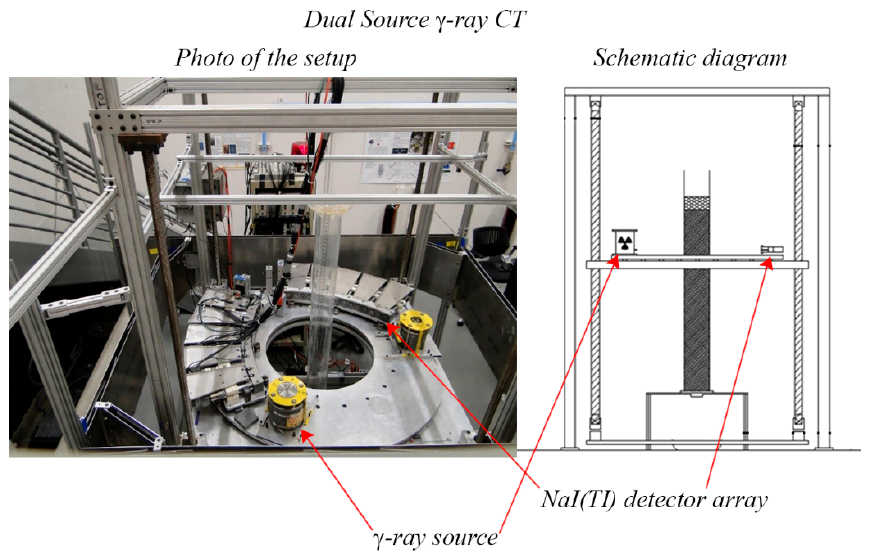
Figure 5. Details of the Dual Source γ -ray Computed Tomography technique.